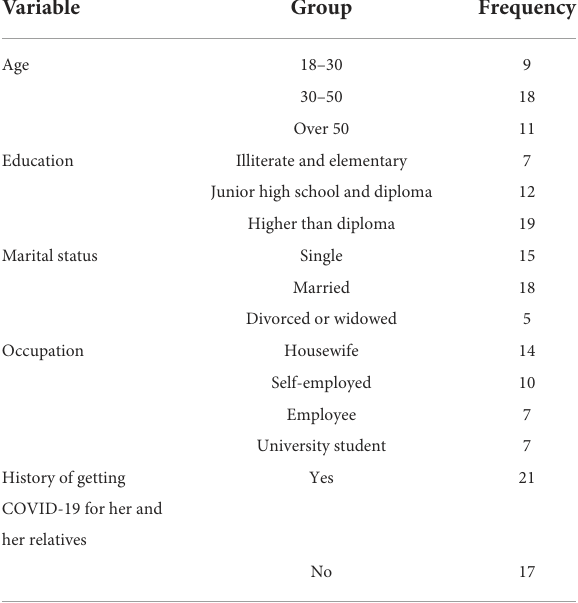
TABLE 2 Demographic information of the